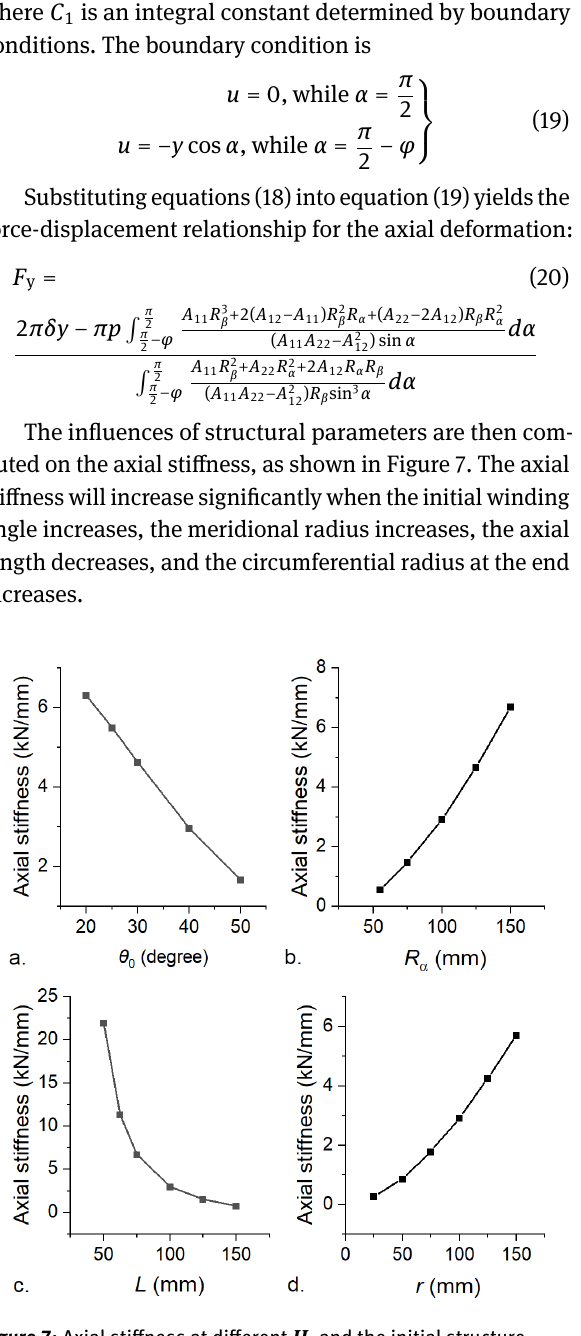
Figure 7: Axial stiffness at different H , and the initial structure vector H 0 = [0.1, 0.1, 0.1, 40] : (a) varied initial winding angle θ 0 ; (b) varied meridional radii R α ; (c) varied axial lengths L; (d) varied circumferential radii at the ends r